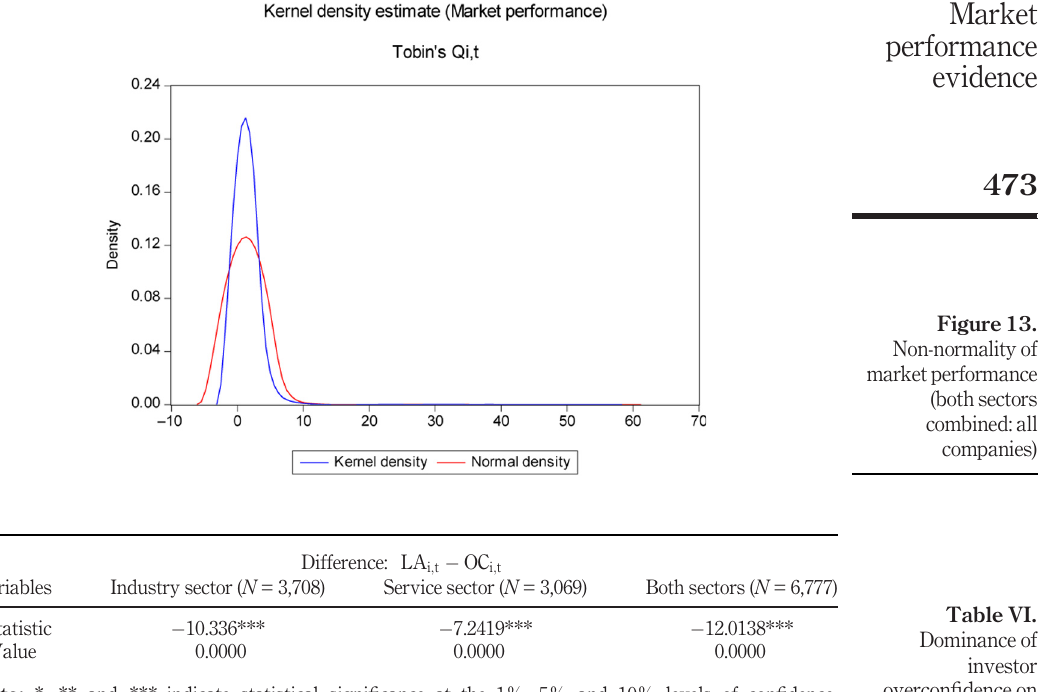
investor overcon fi dence